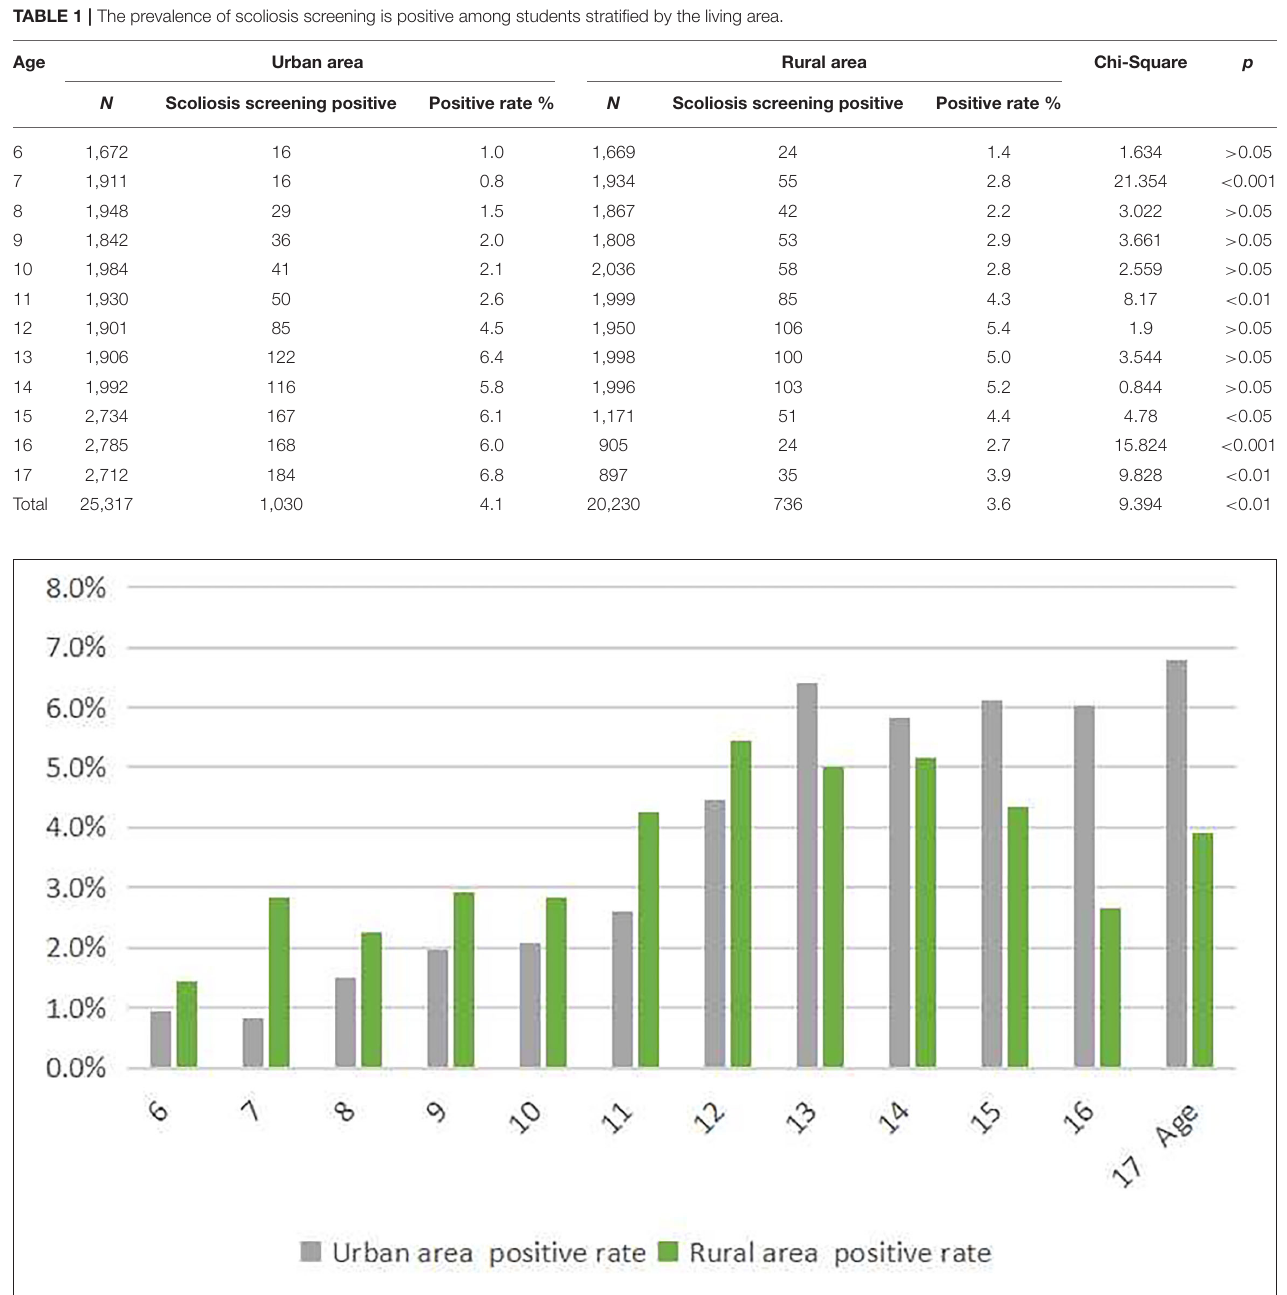
FIGURE 1 | The prevalence of scoliosis screening positive among children and adolescents stratified by the living area.